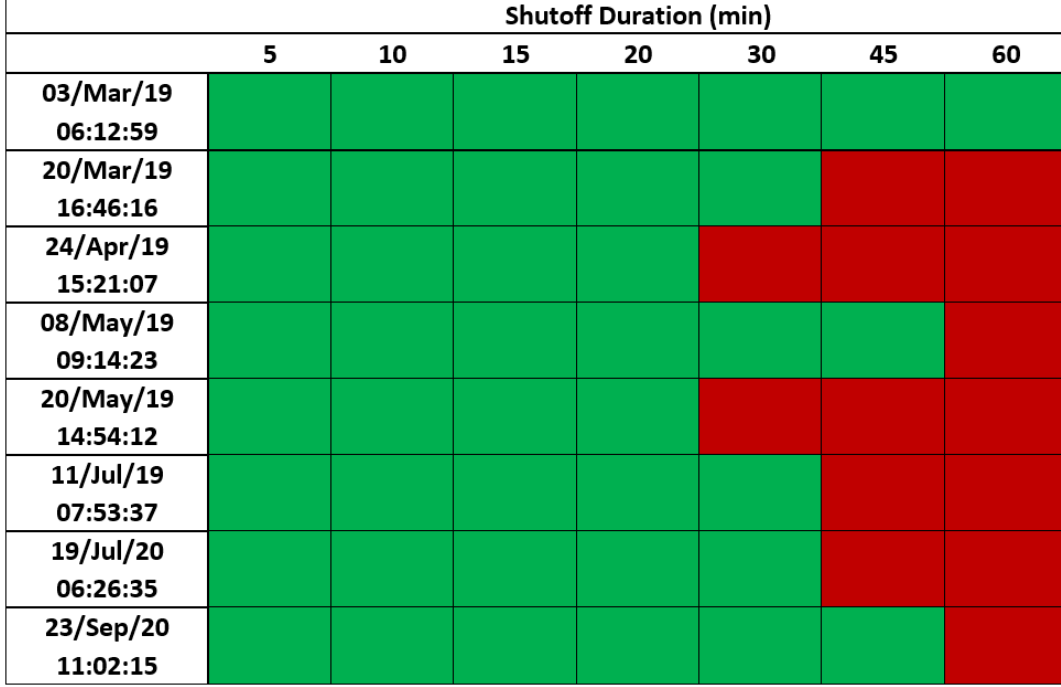
Figure 7. Box-and-whisker plot of indoor air temperature drift for all durations on each grid frequency event day, with median represented by an internal green horizontal line. 3.1.6. Final Implementation (Step 6) Based on the asset selection, categorisation and risk assessment process completed on the case study site it was found that the six assets classified as level 1 would be suitable for DR and electricity market participation. Of these assets, the five AHUs and one CHP unit located in the same building could form a useful flexible capacity, either individually or as an aggregated response portfolio. In this case, scaling the combined capacity of the